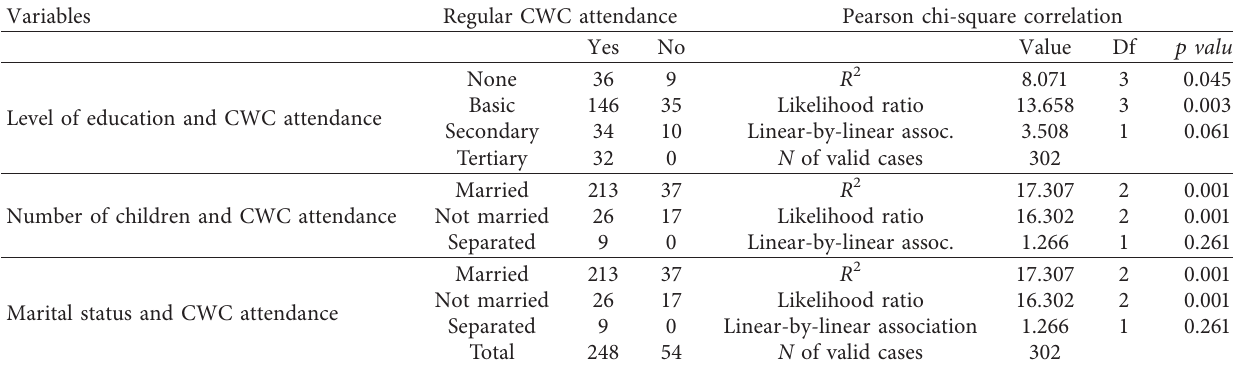
Table 2: Cross tabulation of demographic characteristics and CWC